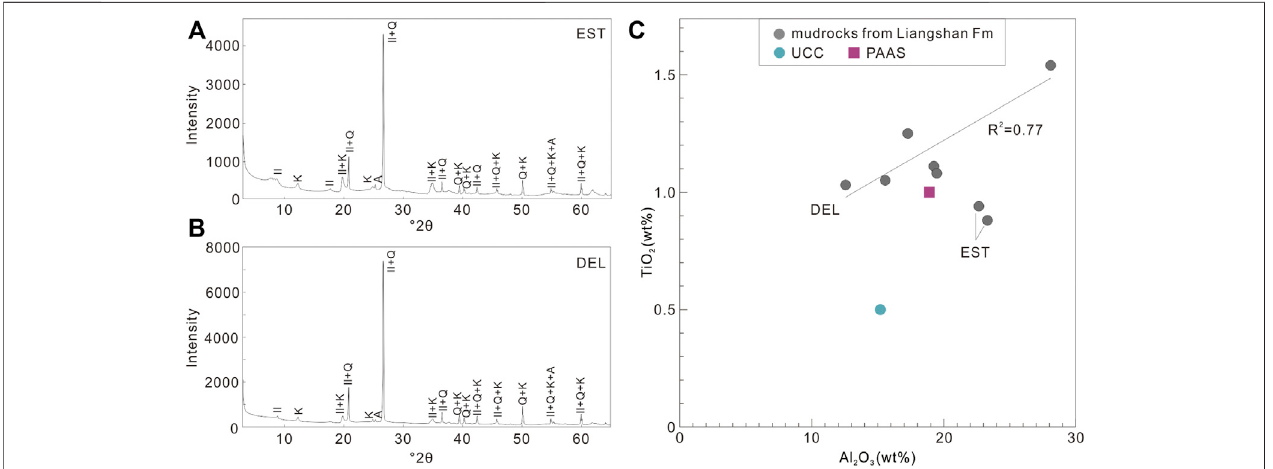
FIGURE 7 | XRD spectra ofmudrock samples of the Liangshan Formation from (A) estuarine and (B) deltaic environments. (C) Al 2 O 3 -TiO 2 cross-plot for mudrock samplesoftheLiangshanFormation.Notingthepositivecorrelation( R 2 =0.77)ofAl 2 O 3 andTiO 2 forthedeltaicmudrocksamples.DataforPAAS(post-Archeanaverage Australian shale) and UCC (upper continental crust) from Taylor and McLennan (1985) are also shown for comparison. Abbreviations: Il, illite; K, kaolinite; Q, quartz; A,